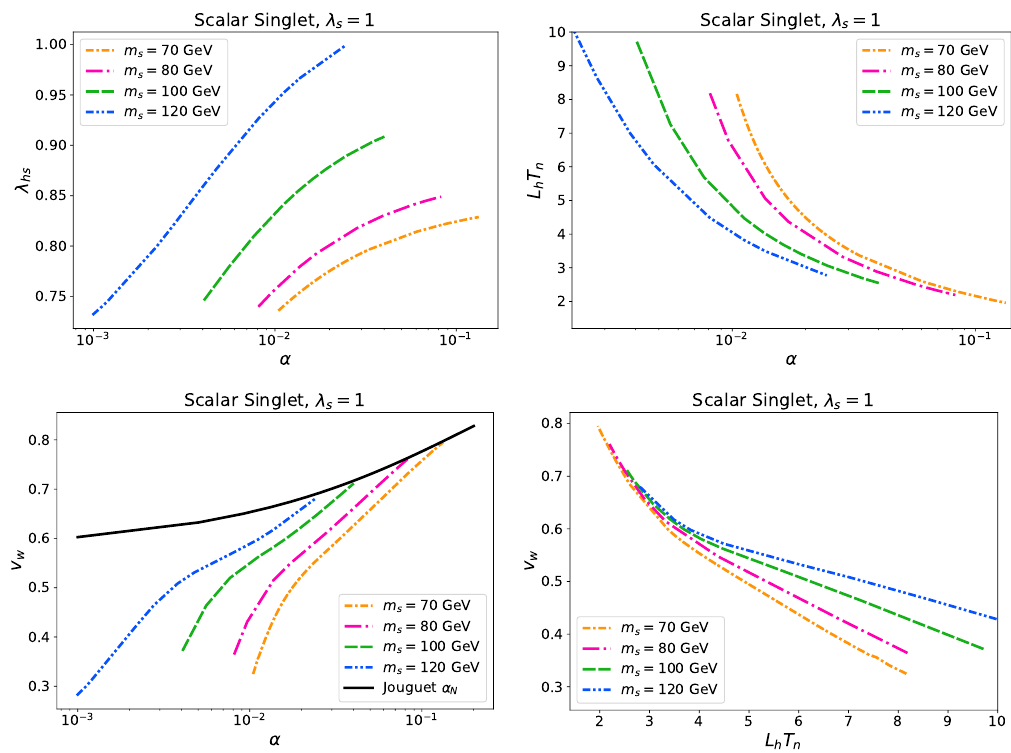
Figure 7 . Results of the calculation for the bubble wall properties in the scalar singlet model for different m benchmarks. We have set λ = 1 everywhere and the qualitative description for each s s figure is provided in the